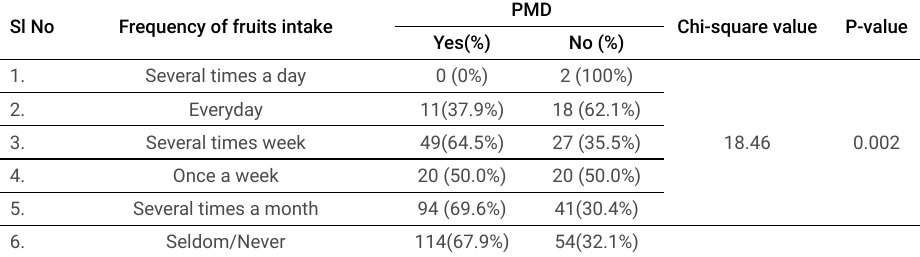
Table 8. Distribution of subjects according to frequency of fruits intake and PMD Sl No Frequency of fruits